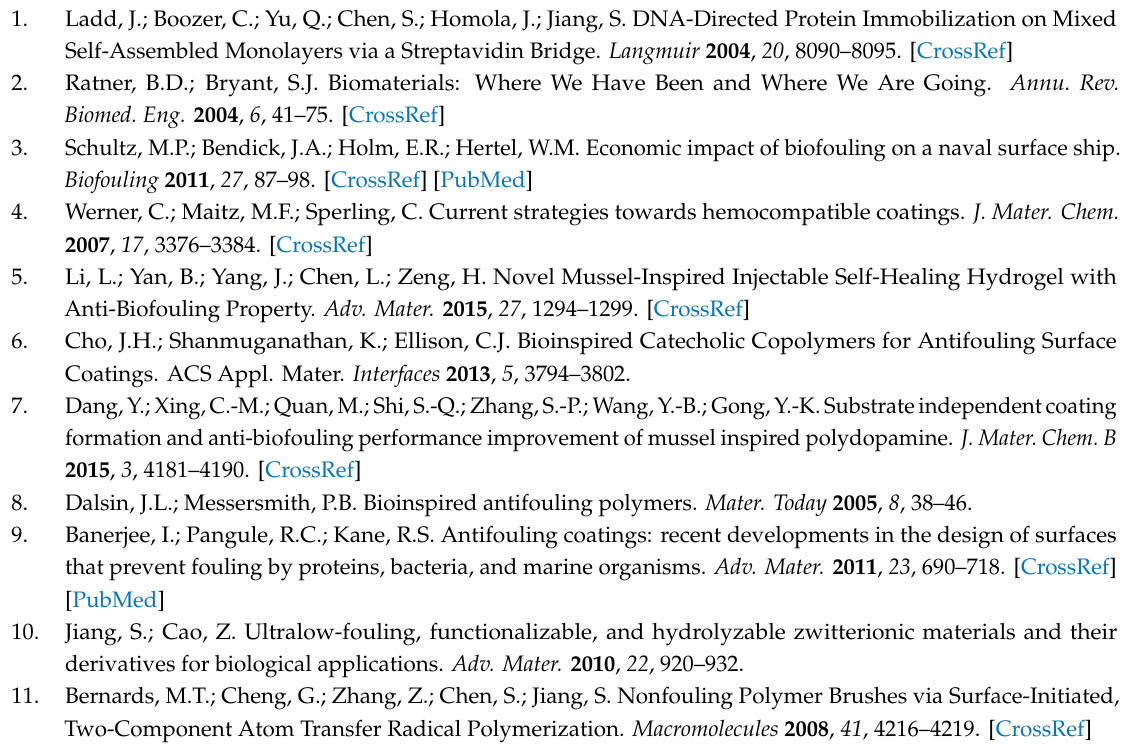
Figure S1. FTIR spectra of P4VP, P1, P2, P3 and P4, Figure S2. GPC traces of P4VP, P1, P2, P3 and P4 in THF, Figure S3. Survey XPS data for Bare ITO surface, Figure S4. Survey XPS data for P4VP polymer surface, Figure S5. Survey XPS data for P1 polymer surface, Figure S6. Survey XPS data for P2 polymer brush surface, Figure S7. Survey XPS data for P3 polymer surface, Figure S8. Survey XPS data for P4 polymer surface, Figure S9. Survey XPS data for CP20 polymer surface, Figure S10. Survey XPS data for CP40 polymer surface, Figure S11. Survey XPS data for CP60 polymer